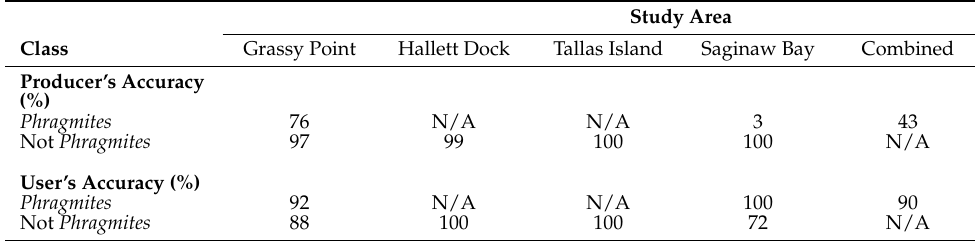
Table 8. Classification performance for all four study sites when using the RGB UAS imagery with a UAS-derived CHM. Producer’s accuracy and user’s accuracy are provided for each study site. Only the accuracy of the Not Phragmites class was calculated for Hallett Dock and Tallas Island. The combined accuracy of the Not Phragmites class was not